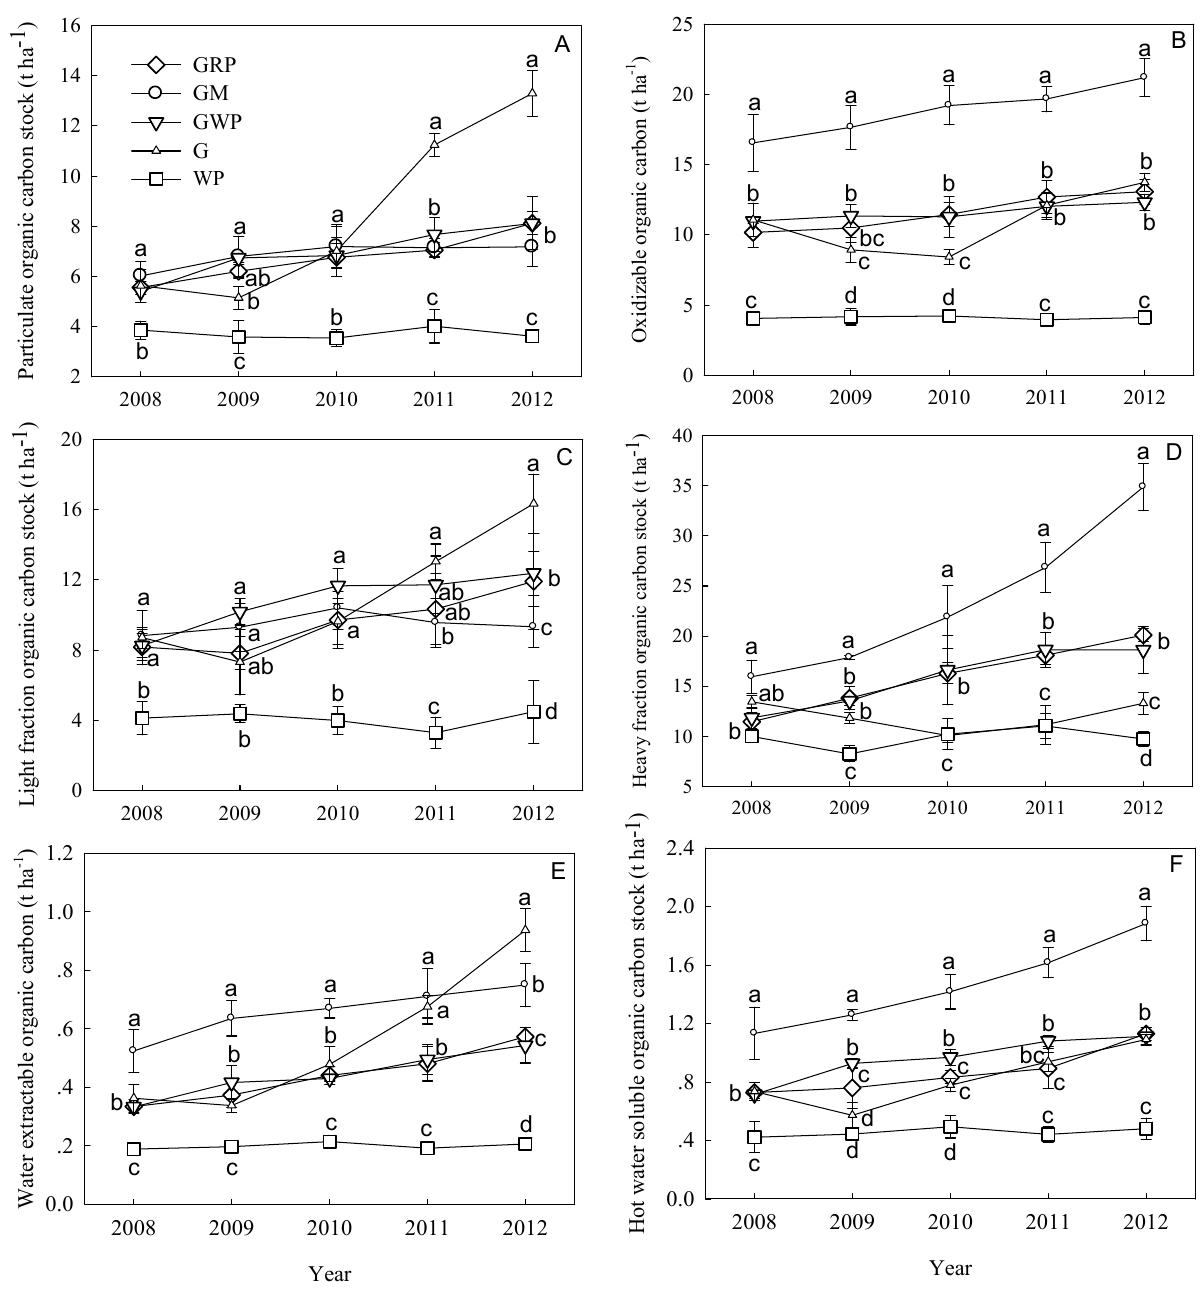
0.0.2.4.6.81.01.2 Figure 2. Particulate ( A ), oxidizable ( B ), light fraction ( C ), heavy fraction ( D ), water extractable ( E ) and hot water soluble ( F ) organic carbon stocks in the 0–20 cm soil layer for five planting treatments, over the years 2008–2012. Vertical bars are the standard deviation ( n = 3). Letters denote significant differences among treatments within a given year ( p < 0.05). Abbreviations: GRP, Ginkgo + rapa + peanut; GM, Ginkgo + mulberry; GWP, Ginkgo + wheat + peanut; G, Ginkgo afforestation; and WP, wheat + peanut. Note differences between panels in the ordinate